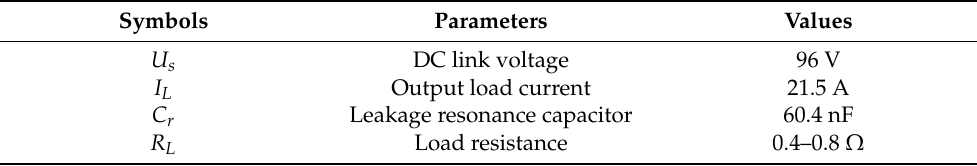
Table 4. Result of prototype (Charging and fault)